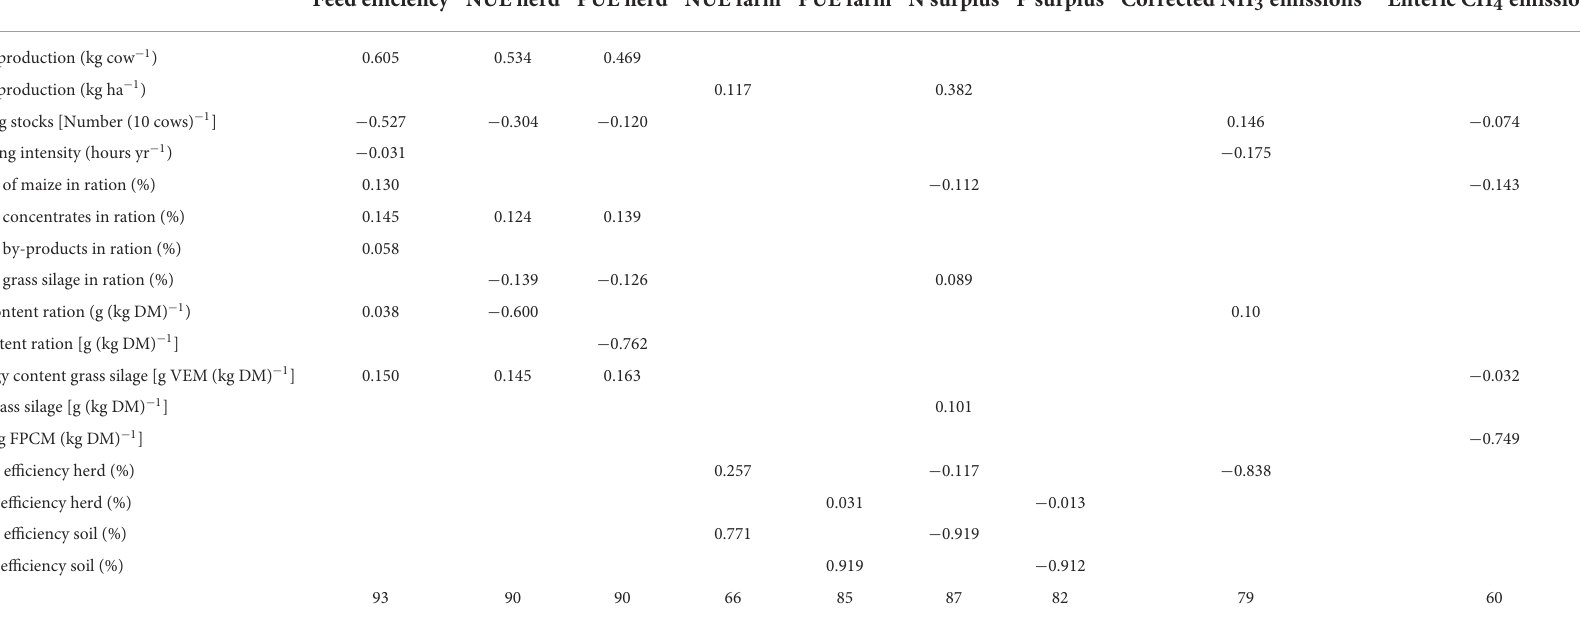
TABLE 3 Results multiple regression analysis. Predictors (explanatory variables) Standardized regression coefficients for farm performance